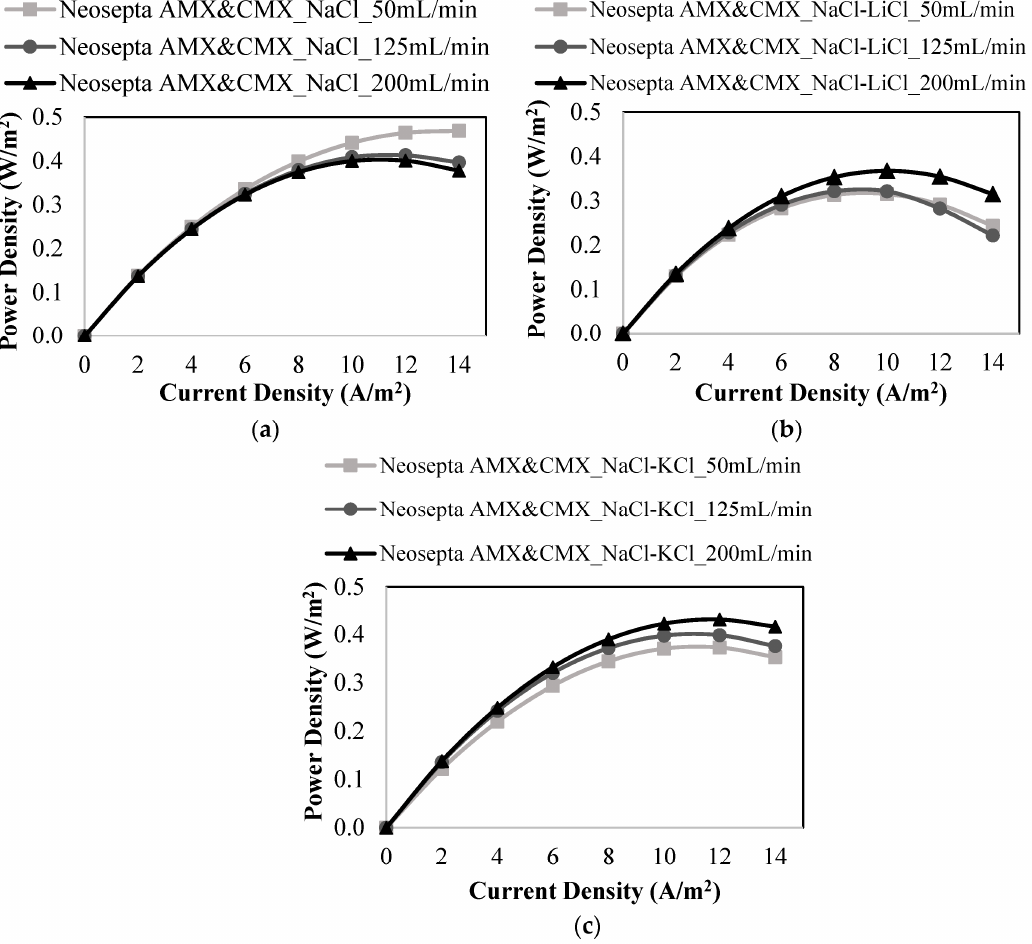
Figure 6. Power density vs. current density plots at different feed flow rates for the studies performed with ( a ) only NaCl, ( b ) a mixture of NaCl and LiCl, ( c ) a mixture of NaCl and KCl using Neosepta AMX & CMX membranes.